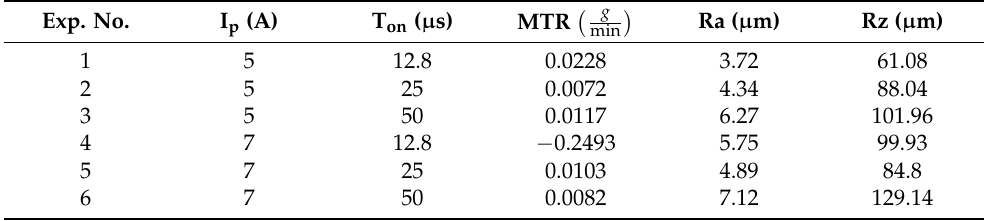
Table 3. Experimental